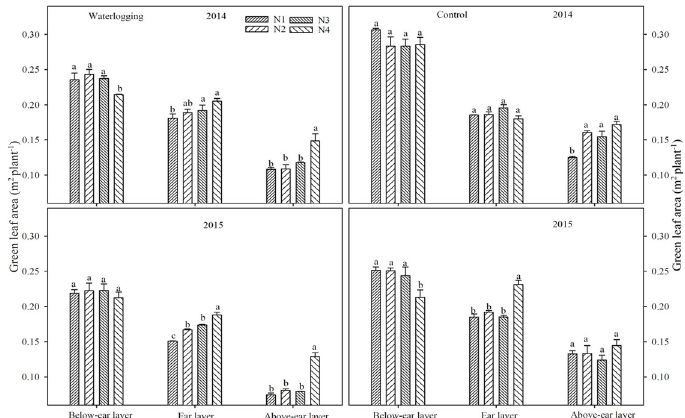
Fig 2. Green leaf area of different leaf layers at the silking stage. The error bars represent the standard errors of the mean. Different letters above the bars indicate significant differences (p < 0.05) among different N regimes. N1: 100% N applied as basal fertilizer, N2: 70% N applied as basal fertilizer and 30% N applied at the jointing stage, N3: 50% N applied as basal fertilizer and 50% N applied at the jointing stage, N4: 30% N applied as basal fertilizer, 50% N applied at the jointing stage and 20% N applied at the big flare